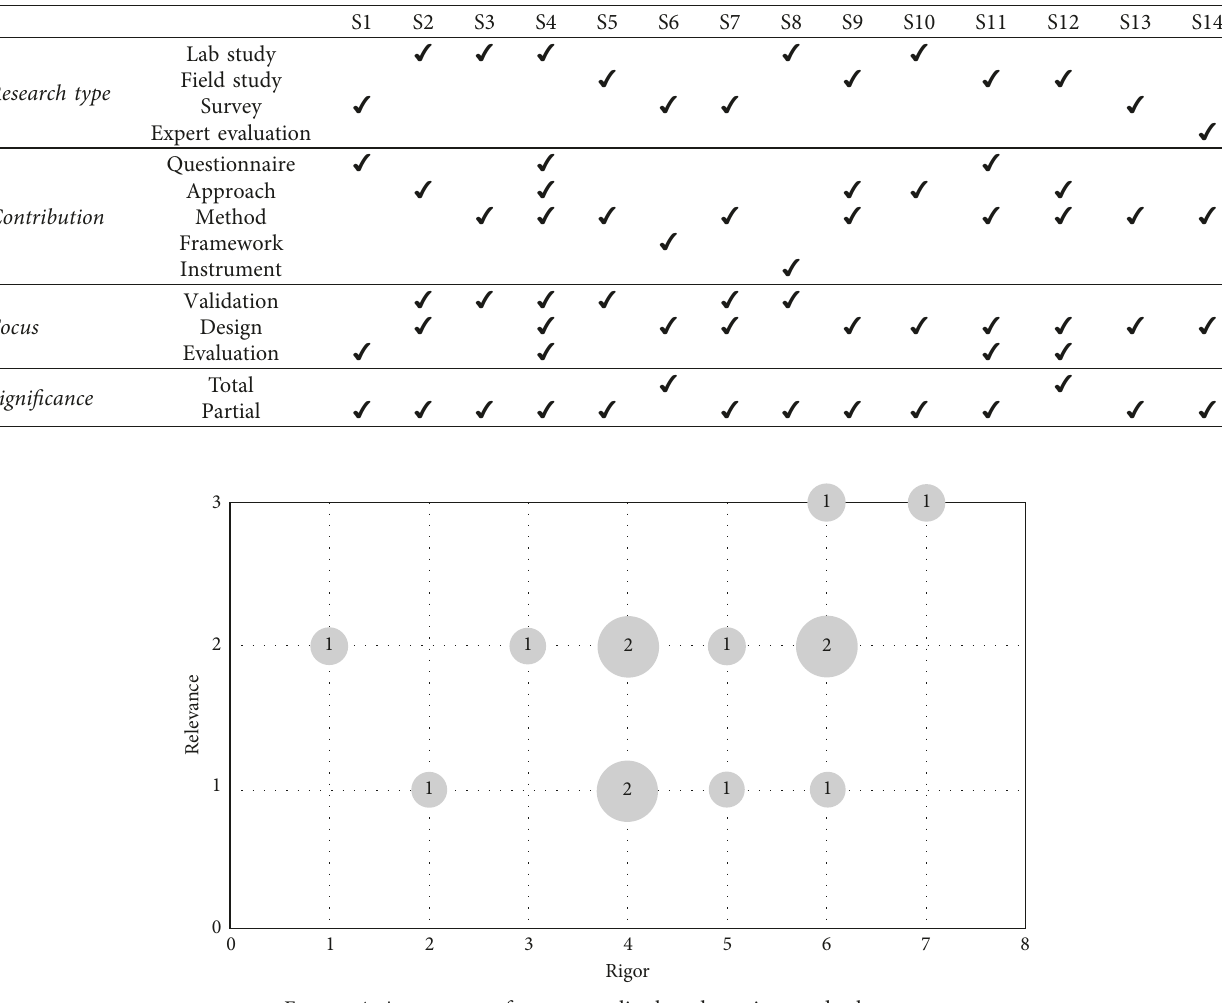
Figure 4: Assessment of papers quality based on rigor and relevance.